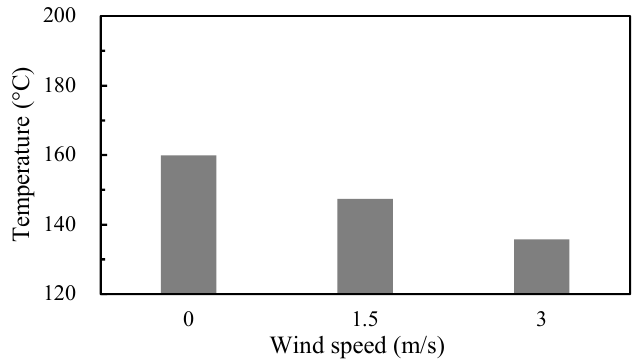
Figure 11. Maximum junction temperature of the inverter switches under forced convection with two different wind speeds.